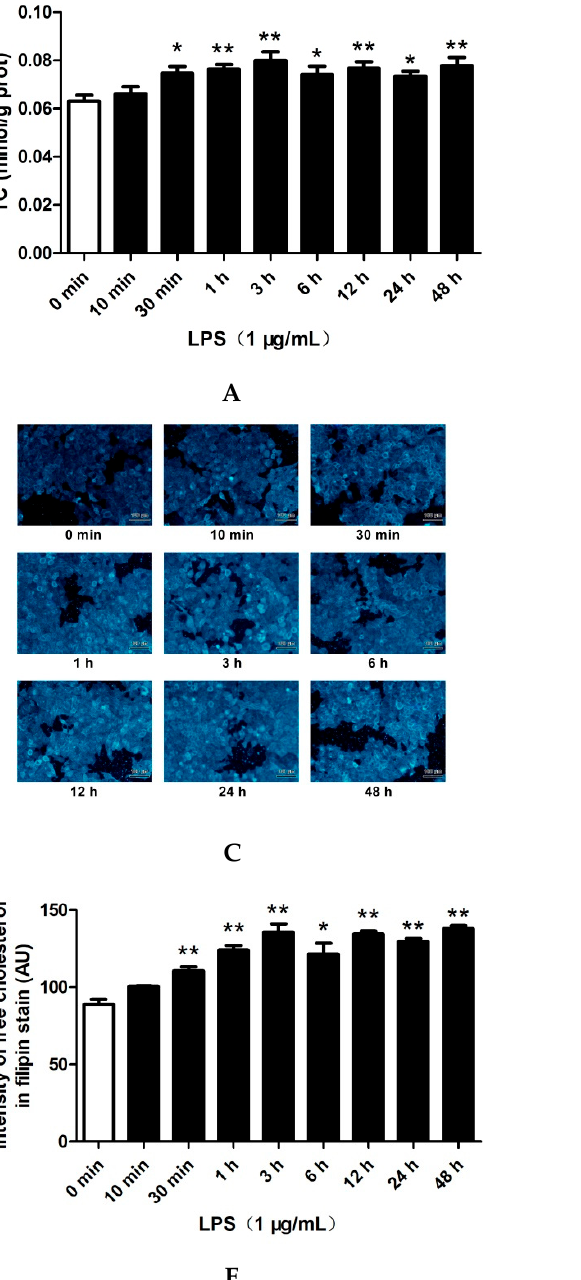
Figure 2. Effects of LPS and PA on cholesterol content in HepG2 cells. Cells were treated with LPS (1 μ g/mL) or PA (200 μ mol/L) for different times (0 min, 10 min, 30 min, 1 h, 3 h, 6 h, 12 h, 24 h, and 48 h). Intracellular total cholesterol (TC) was determined with a commercial kit ( A , B ). Intracellular free cholesterol was visualized by filipin staining ( C , D ) and quantified using ImageJ and SPSS20.0 software ( E , F ). The results are presented as means ± SD of three independent experiments; *: p < 0.05 vs. 0 min, **; p < 0.01 vs. 0 min.